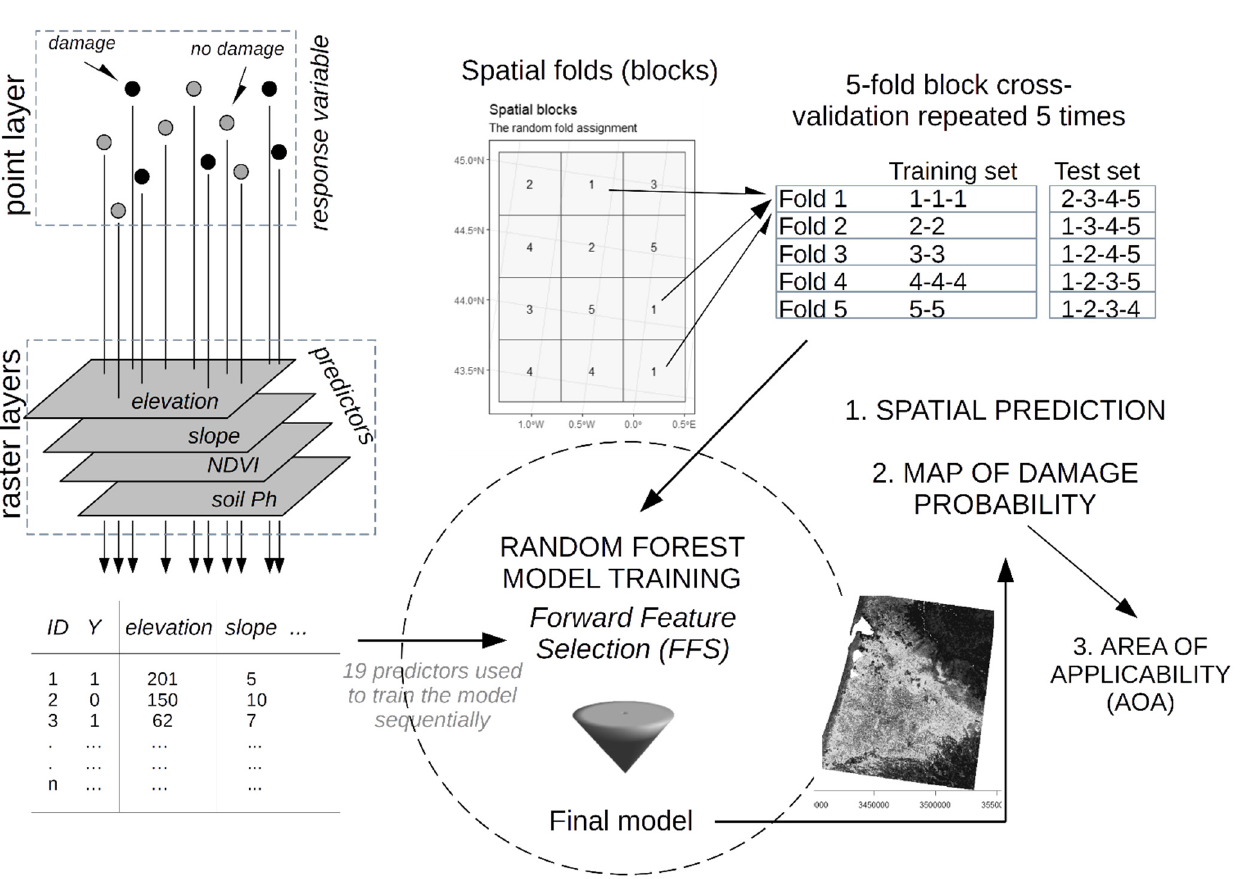
Figure 3. Modelling pattern adopted in the present study. The subsequent stages show raster layers sampling based on points, block cross-validation, random forest model training, the construction of map of forest damage probability, and final validation with the area of applicability (AOA) technique.